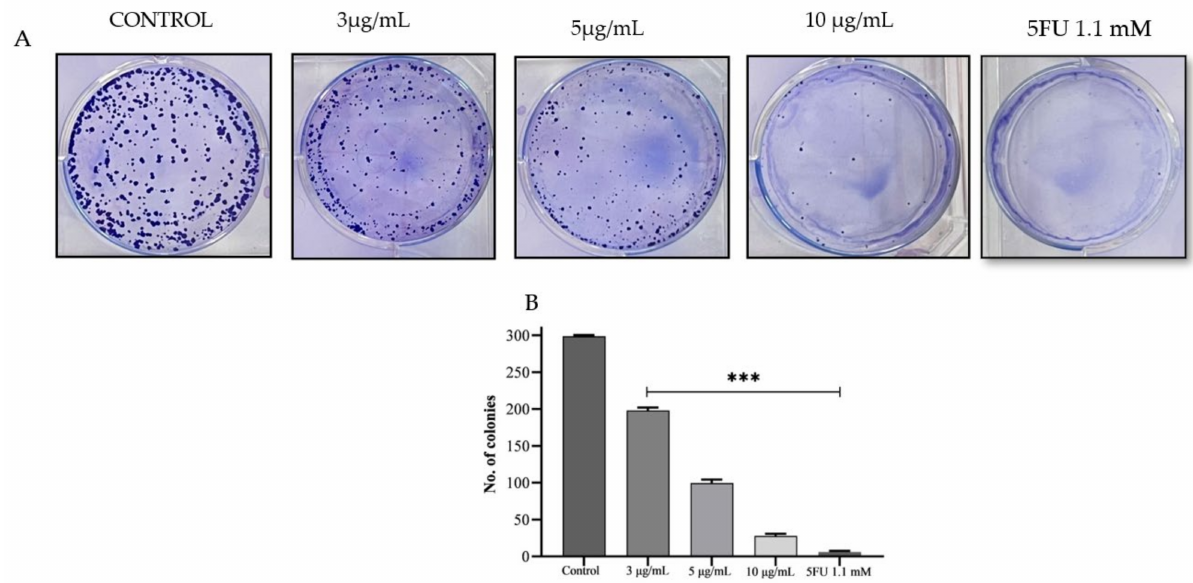
Figure 3. HCT-116 cells with density 600–700 were seeded and treated with PPE (3–10 µ g/mL) and 5FU (1.1 mM). After 24 h, the extract was removed and replaced with fresh media, and the colony- forming capability was observed for 10 days and stained with crystal violet. ( A ) A dose-dependent decrease in the number of colonies; ( B ) Graphical representation of the number of colonies of HCT-116 treated with increasing doses of PPE. The values indicate ± SD ( n = 3); *** p < 0.001 vs.